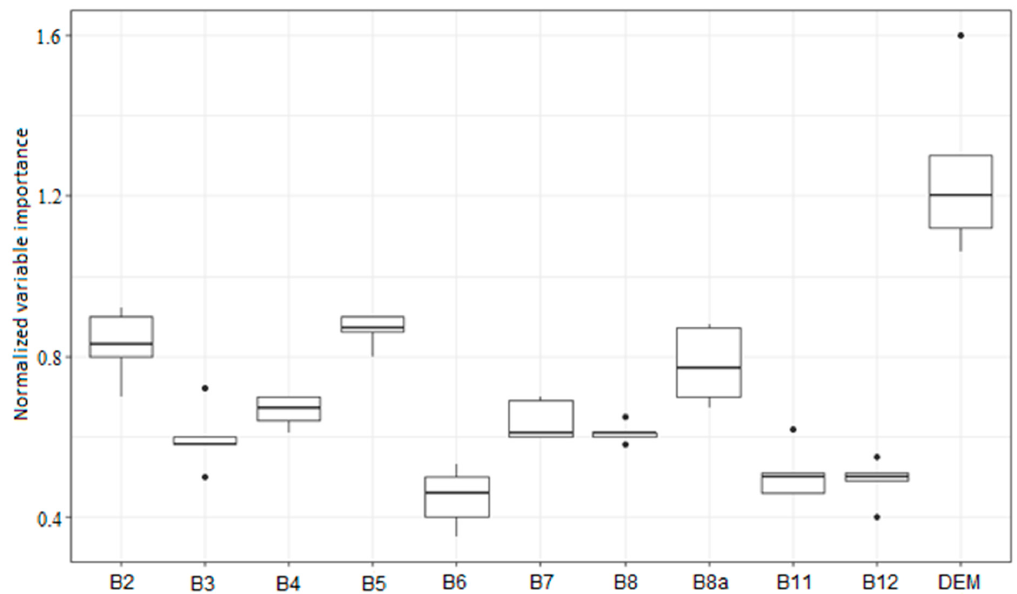
Figure 5. Normalized variable importance for the most accurate classification of the forest cover derived using the combination of 10 m (B2, B3, B4, B8), 20 m (B5, B6, B7, B8a, B11, B12) resolution bands and DEM (11 variables).